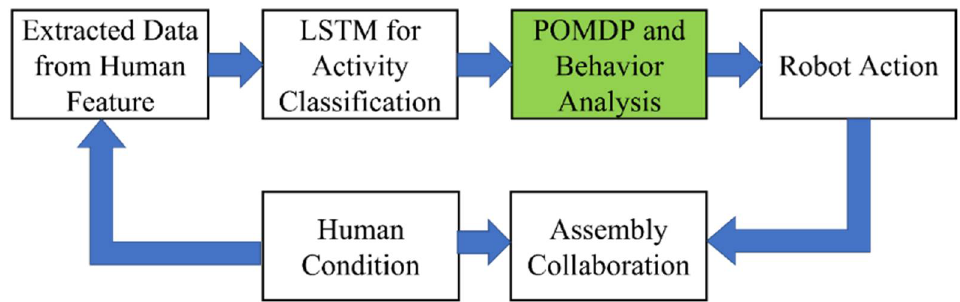
Figure 5. A Framework System of POMDP and Behavior Analysis.